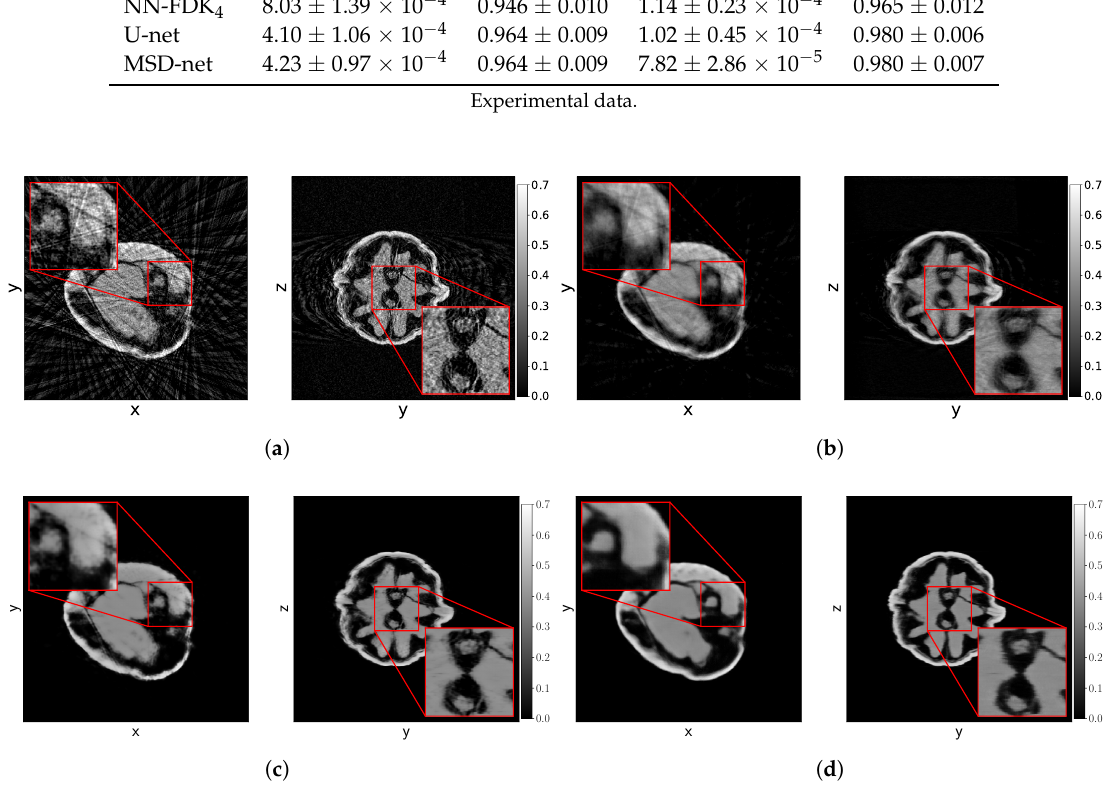
reconstruction. ( c ) NN-FDK 4 reconstruction. 200